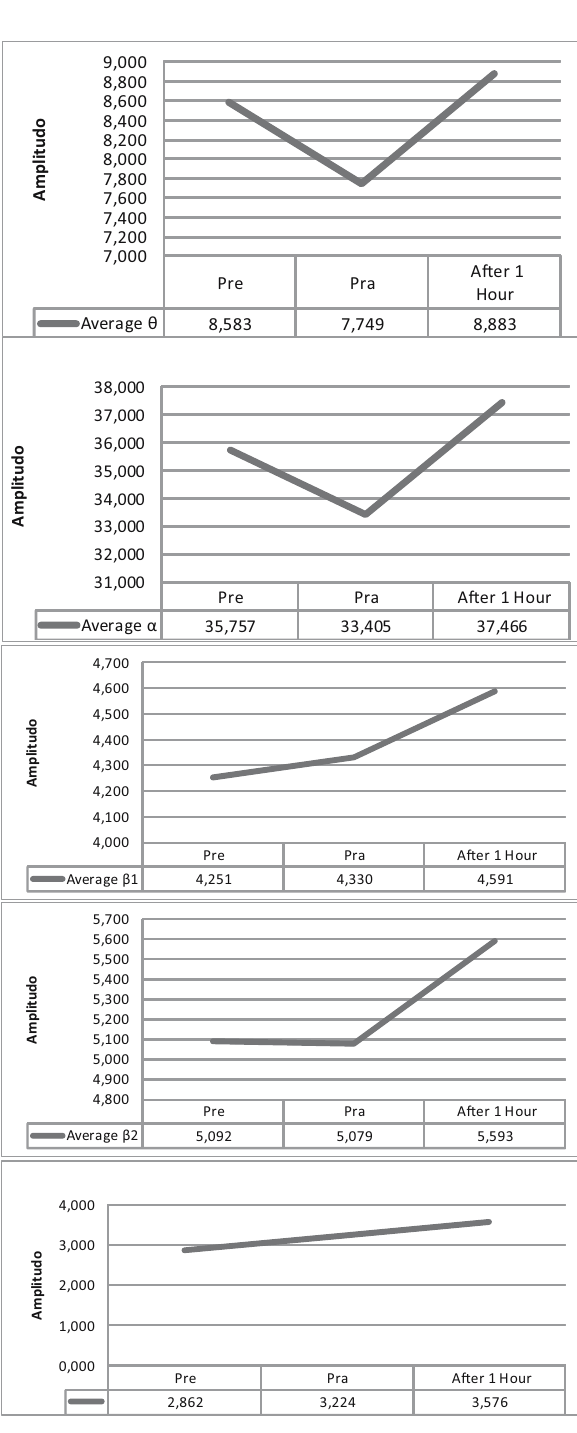
Figure 4: The average increase in maximum amplitude of each wave for subjects before and after consuming soy